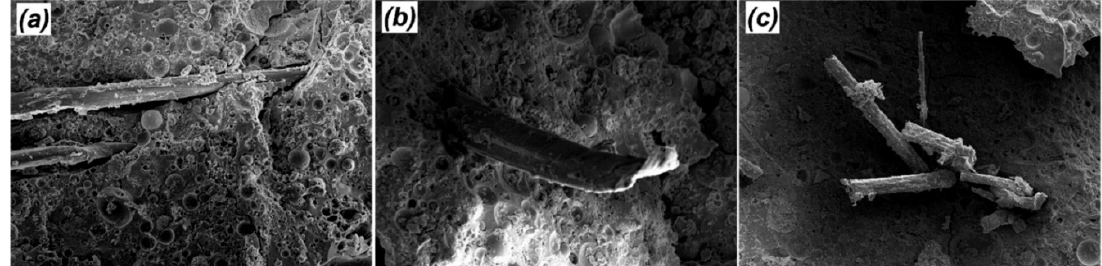
Figure 5. Scanning electron microscopy (SEM) images of flax fiber-reinforced geopolymer concrete; ( a ) geopolymer with flax fibers, ( b ) geopolymer with flax fibers and nano-silica (dry-mix) ( c ) geopolymer with flax fibers and nano-silica (wet-mix). Reprinted from Reference [57] under open access license.